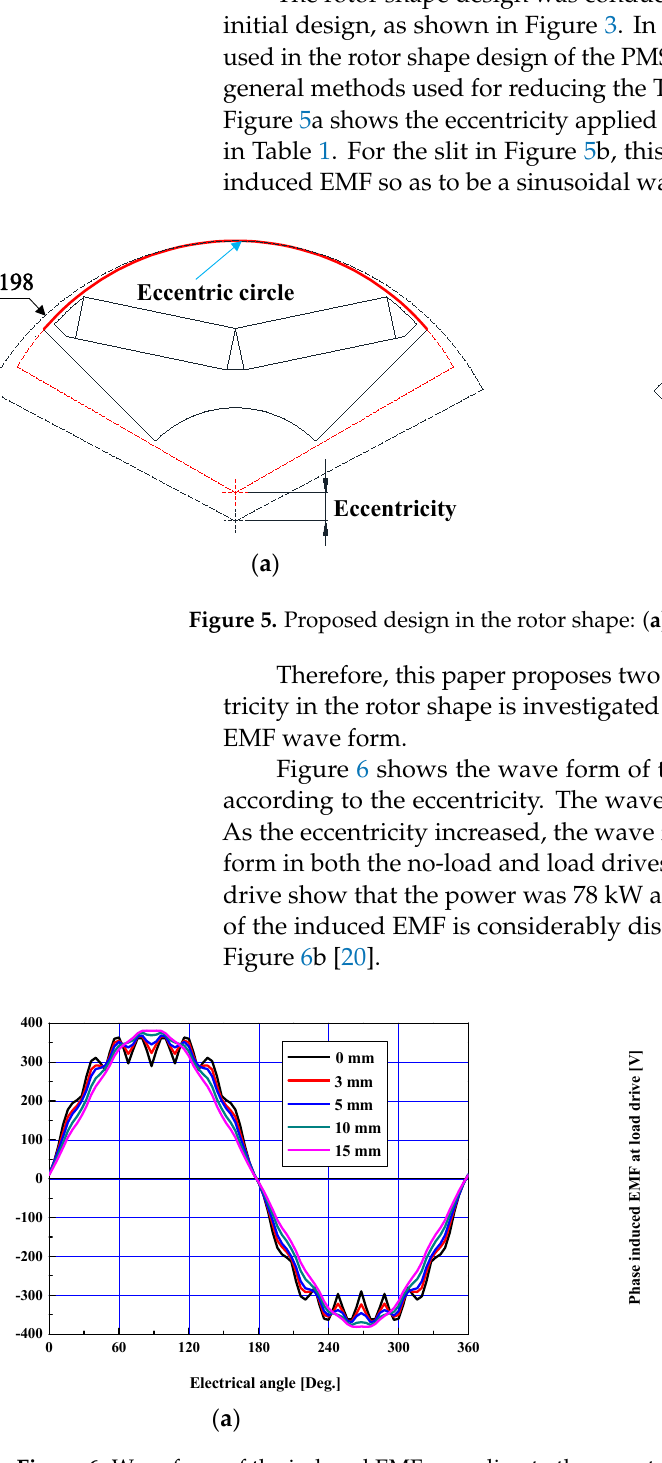
( b ) Figure 7. Induced EMF at no-load and load drives according to the eccentricity: ( a ) fundamental component, and ( b ) THD. The change rate means the percentage of the induced EMF for the two eccentricities was 0 and 15 mm. Accordingly, the change rates for the induced EMF were relatively small according to the eccentricity. In case of the induced EMF THD at the no-load and load drives, the induced EMF THD decreased as the eccentricity increased. However, in the case of the no-load drive, the THD had a minimum value at the eccentricity of 10 mm and then increased again. Second, the other proposed design was a hybrid model, an eccentric shape including the slit shape of Figure 5b. Figures 8 and 9 show the wave form and THD for the proposed model at the no-load and load drives. The wave forms in Figure 8 were obtained by 2D FEA. These figures correspond to Figures 6 and 7, respectively. When applying the slit design, the eccentricity increased, and the wave forms of the induced EMF at the no-load and load drives moved closer to a sinusoidal wave form in a similar way to Figure 6.